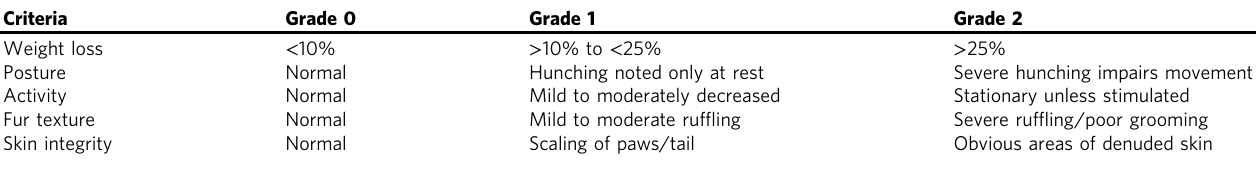
Table 1 Assessment of clinical GvHD in transplanted animals